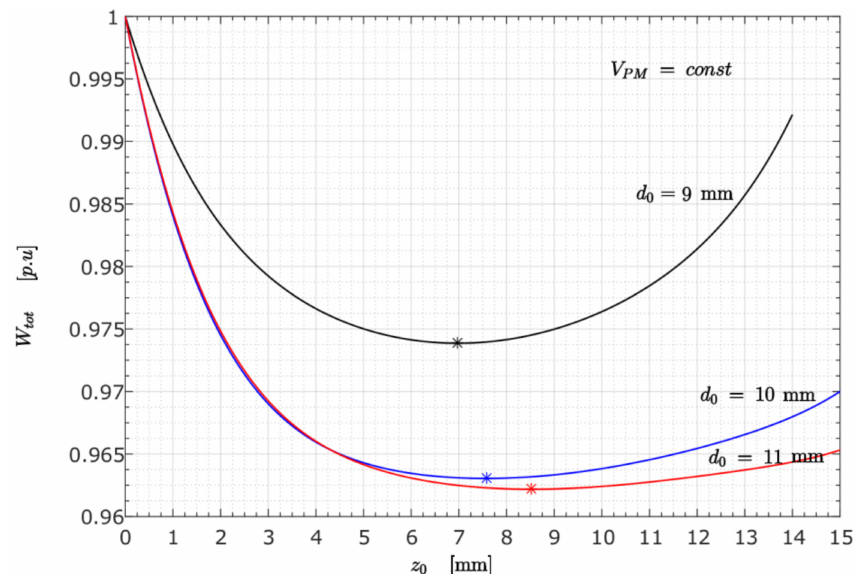
Figure 21. The PM’s equilibrium height calculated by EM. The results are shown for three different values of the PM’s diameter, i.e., d 0 = 9 mm, d 0 = 10 mm, and d 0 = 11 mm, respectively. The minimum value on the individual curve is indicated with the Asterisk (*). Each of the curves was normalized by its maximum value. In the calculations, the PM’s volume V PM remained